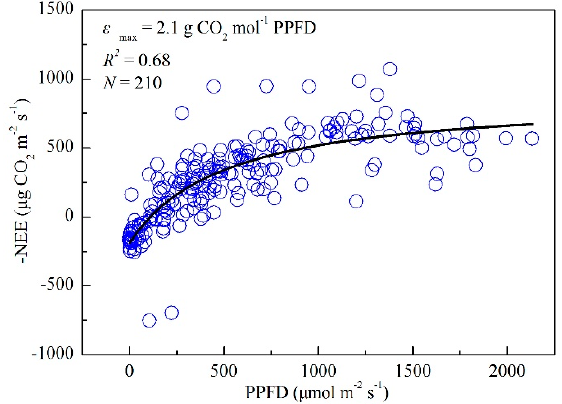
Figure 3. Light-response curve function on July 16–22, 2011, at the XL site.